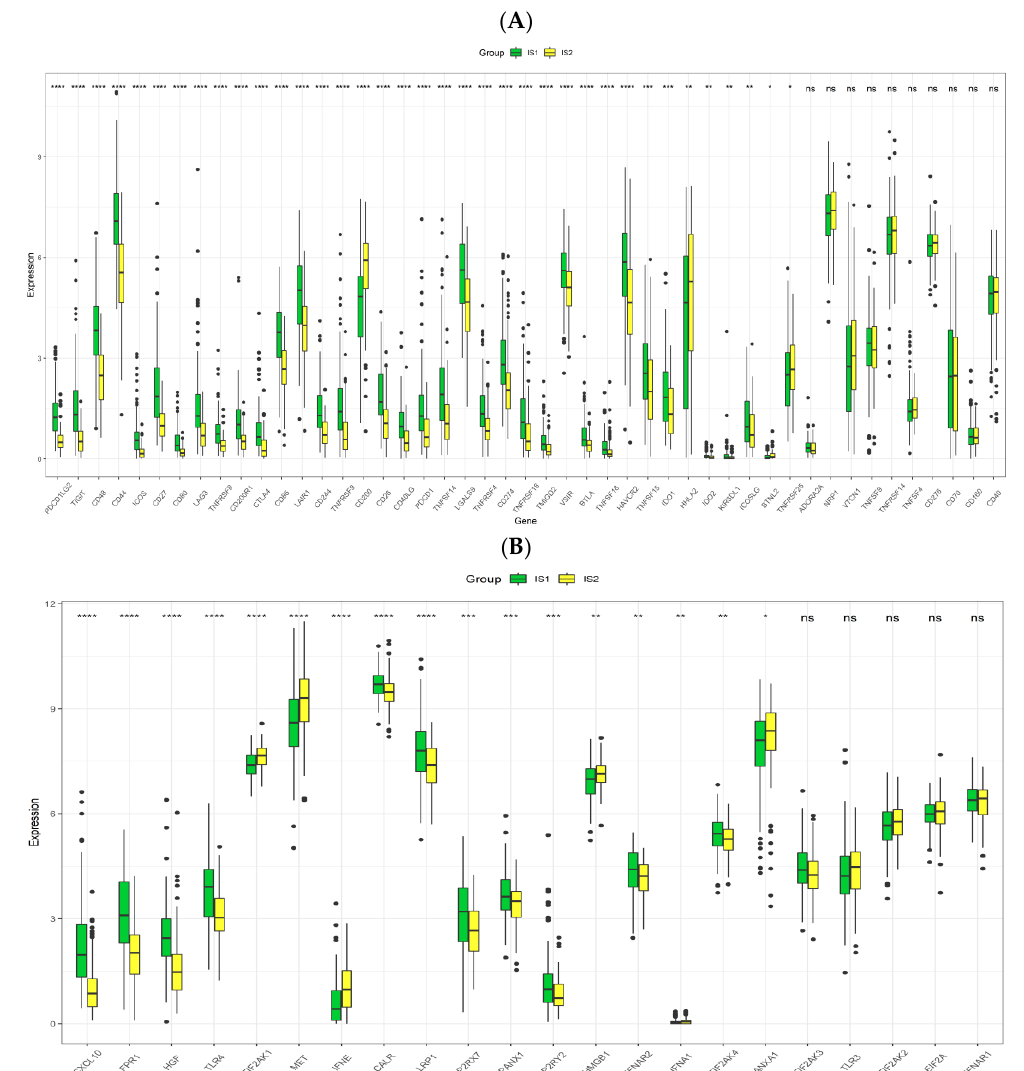
Figure 7. Expression associations between immune subtypes and ICPs and ICD modulators. ( A ) The expression pattern of ICPs among PRCC immune subtypes in the TCGA cohort. ( B ) Expression comparison of ICD modulators between the two subtypes in the TCGA cohort. * p < 0.01, ** p < 0.001, *** p < 0.0001, and **** p <